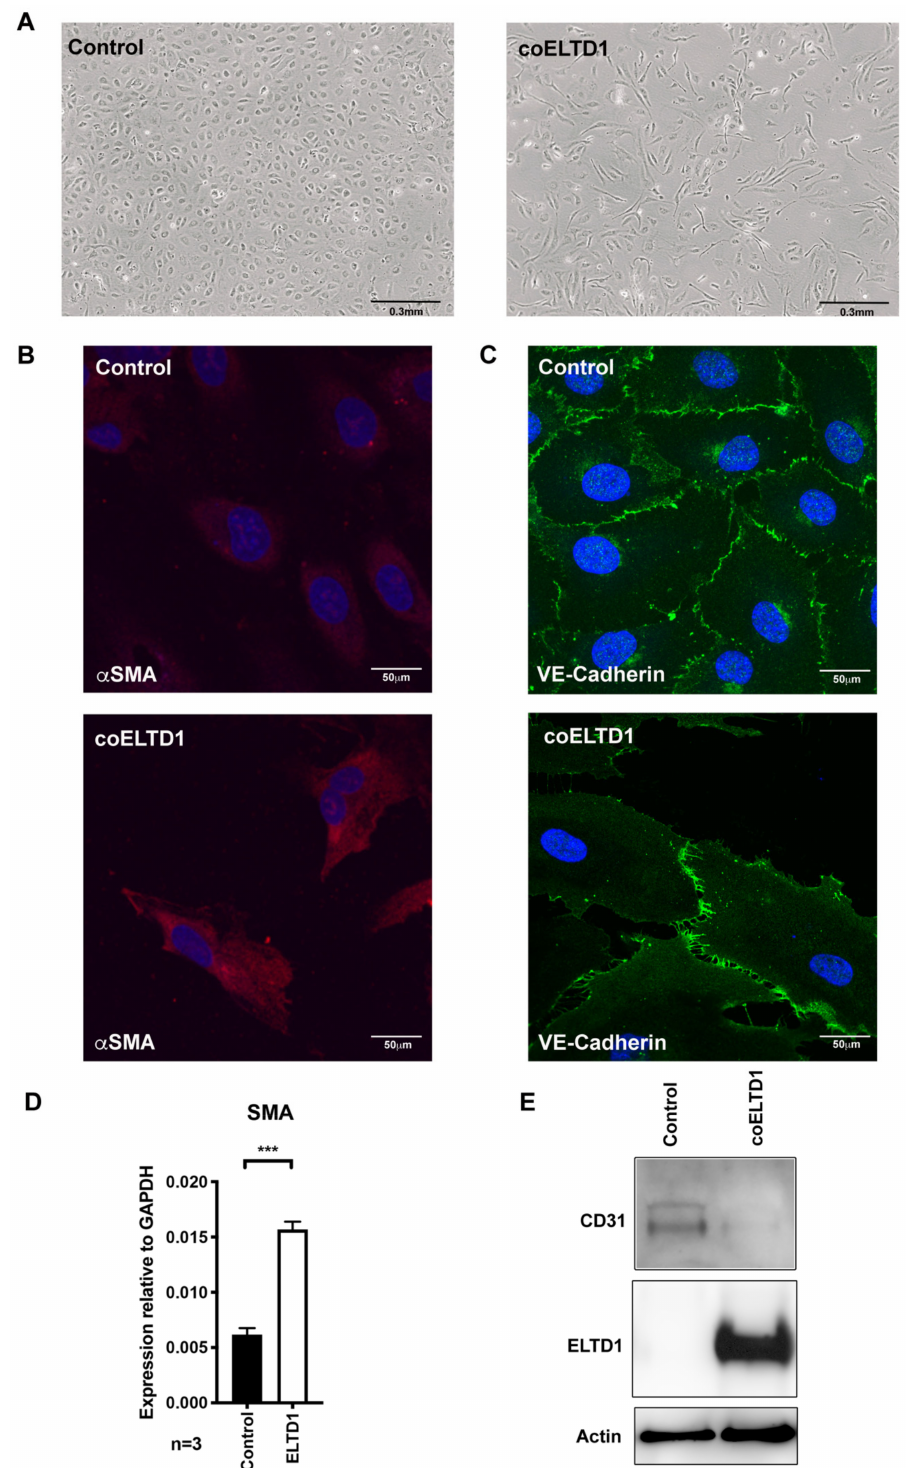
Figure 2. coELTD1 expression induces EndMT. ( A ) Visualization of HUVEC 120 h post infection with control and coELTD1 expressing lentivirus. Images were taken on an AMG Evos XL Core digital microscope (Fisher Scientific, Waltham, MA, USA) at 10 × magnification. ( B ) Fluorescent staining of α SMA in control and coELTD1 expressing HUVEC cells at 120 h. ( C ) Fluorescent staining of VE-Cadherin in control and coELTD1 expressing HUVEC cells at 120 h. Images were taken on a Zeiss LSM 880 Confocal Microscope (Zeiss, Oberkochen, Germany) at 63 × magnification. ( D ) QPCR of α SMA in control and coELTD1 expressing HUVEC. ( E ) Western blot analysis of CD31 expression in control and coELTD1 expressing HUVEC. *** p